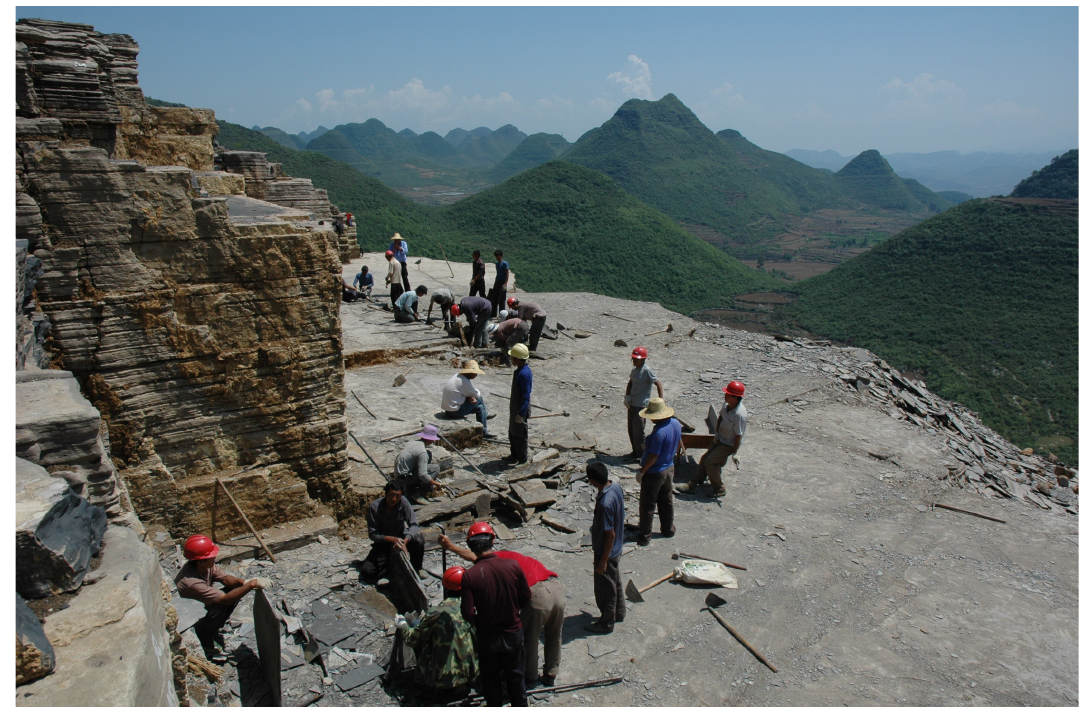
Figure 4. Excavating the Shangshikan Hill site, near Daaozi village, in 2009. Workmen are lifting slabs full of fossil fishes for the museum. Photograph by Q.Y.Z.